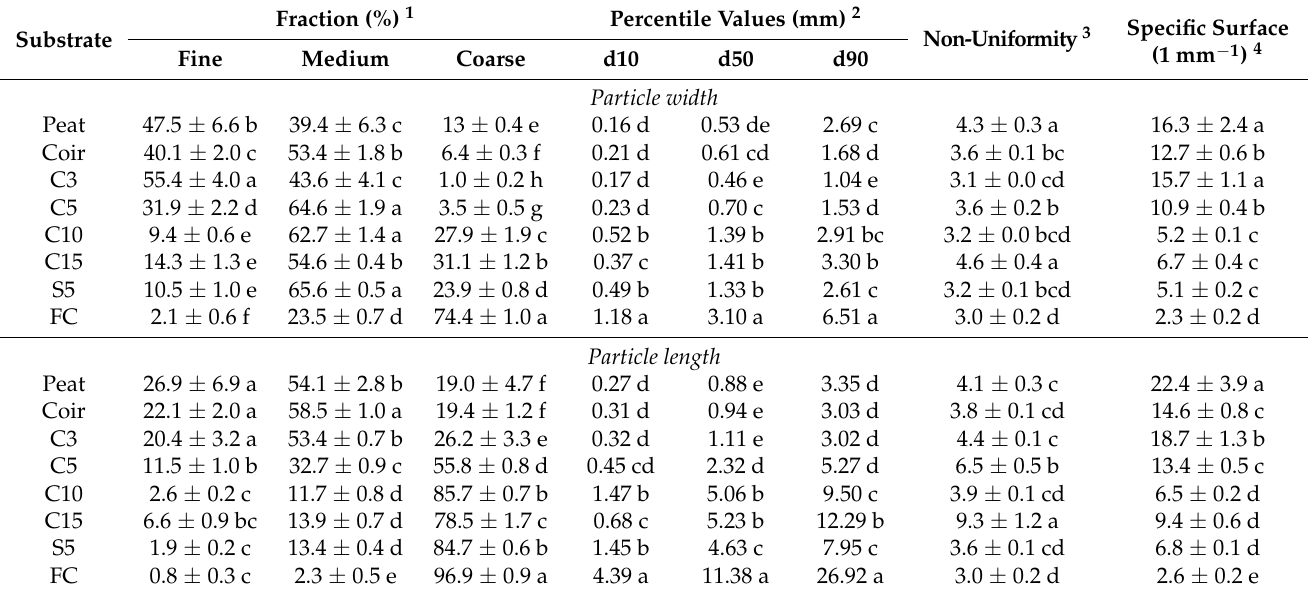
Figure 2. Volumetric distribution of particle size of peat, coir, and processed miscanthus substrates analyzed with dynamic image analysis. The curve represents for mean value of four replicates of each substrate. Miscanthus × giganteus was harvested with a forage harvester (FC, field-chips), then processed with a mechanical fraying facility through a 5-mm screen (S5, shreds) or a hammermill with screen sizes of 15, 10, 5, and 3 mm (C15, C10, C5, and C3 chips). Table 4. Volume-based particle size parameters of peat, coir, and processed miscanthus substrates using dynamic image analysis.